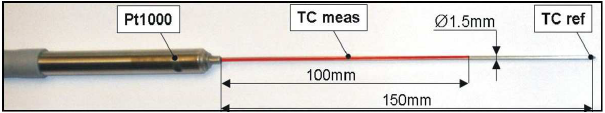
Fig. 1. The commercial TP02 (long needle) thermal conductivity probe produced by the Dutch company Hukseflux. The heated part is indicated in red.